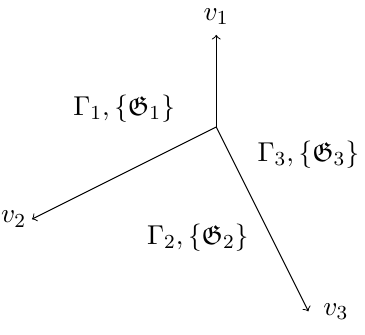
Figure 4 . A fan of an extremal base B o . The fan has three rays with generators v i . Each of the two-dimensional cones is furthermore labelled by a lattice Γ i of blown-down curves and non-minimal gauge groups { G i } over some